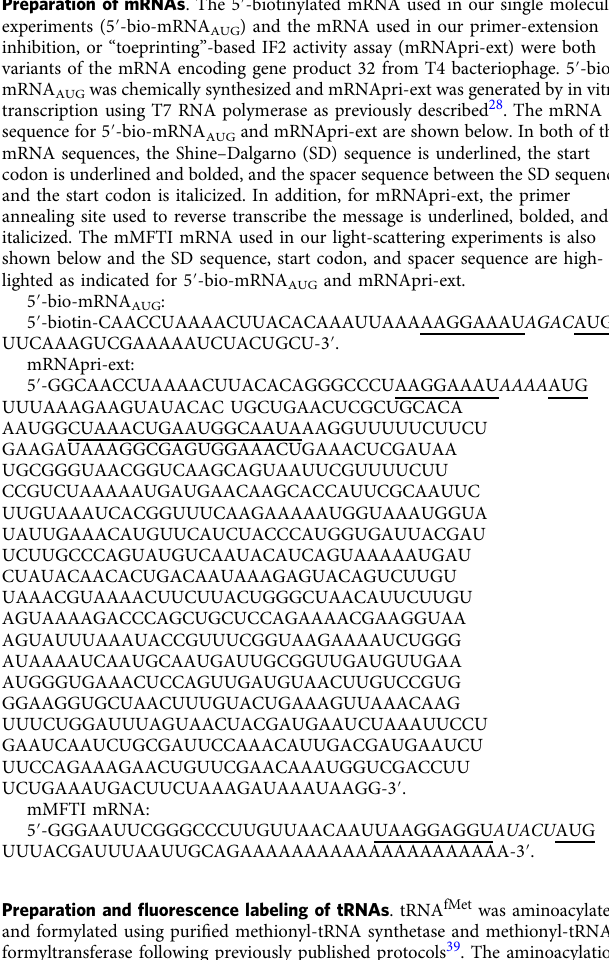
formyltransferase following previously published protocols 39 . The aminoacylation and formylation ef fi ciency was > 90% as determined after separating the tRNA fMet , Met-tRNA fMet , and fMet-tRNA fMet species using a TSKgel Phenyl-5PW hydro- phobic interaction chromatography (HIC) column. tRNA fMet was labeled by reacting its naturally occurring 4-thiouridine at nucleotide position 8 with a maleimide-derivatized cyanine 3, or Cy3, as described previously 28 . Cy3-labeled tRNA fMet was separated from free, unreacted Cy3 by extensive phenol extraction, and from unlabeled tRNA fMet using HIC chromatography. Preparation of 30S ICs . For smFRET experiments, 30S ICs were assembled by combining 0.6 μ M Cy3-labeled initiator tRNA (fMet-tRNA(Cy3) fMet ,